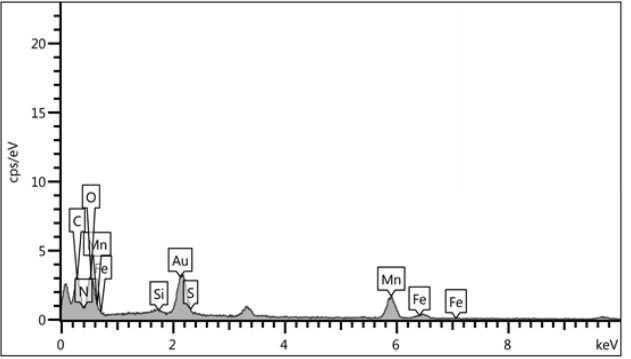
Figure 3. EDX analysis of the Mn-supported nano-catalyst.